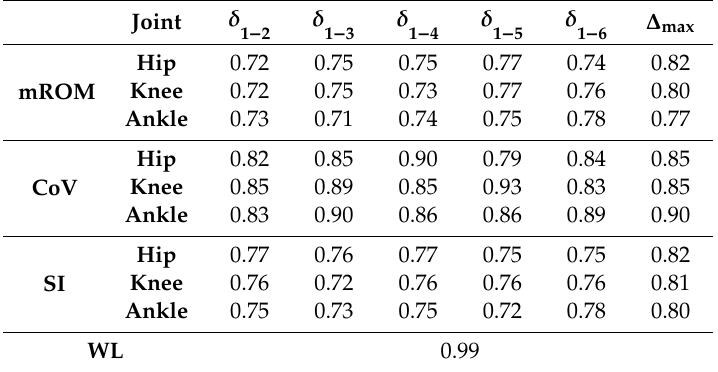
Table 3. ICC values related to the inter-day reliability analysis for synthetic indices related to the 6MWT. We considered together the results for the left and right due to the low value of SI